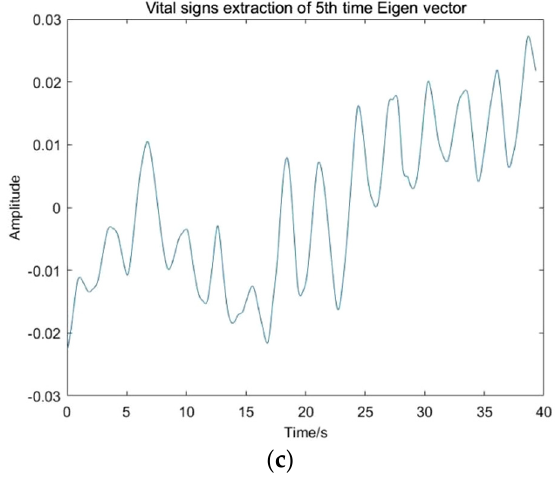
Figure 14. Vital signs extraction results of each principal component: ( a ) Vital signs extraction of first temporal eigenvector; ( b ) Vital signs extraction of second temporal eigenvector; ( c ) Vital signs extraction of third temporal eigenvector.